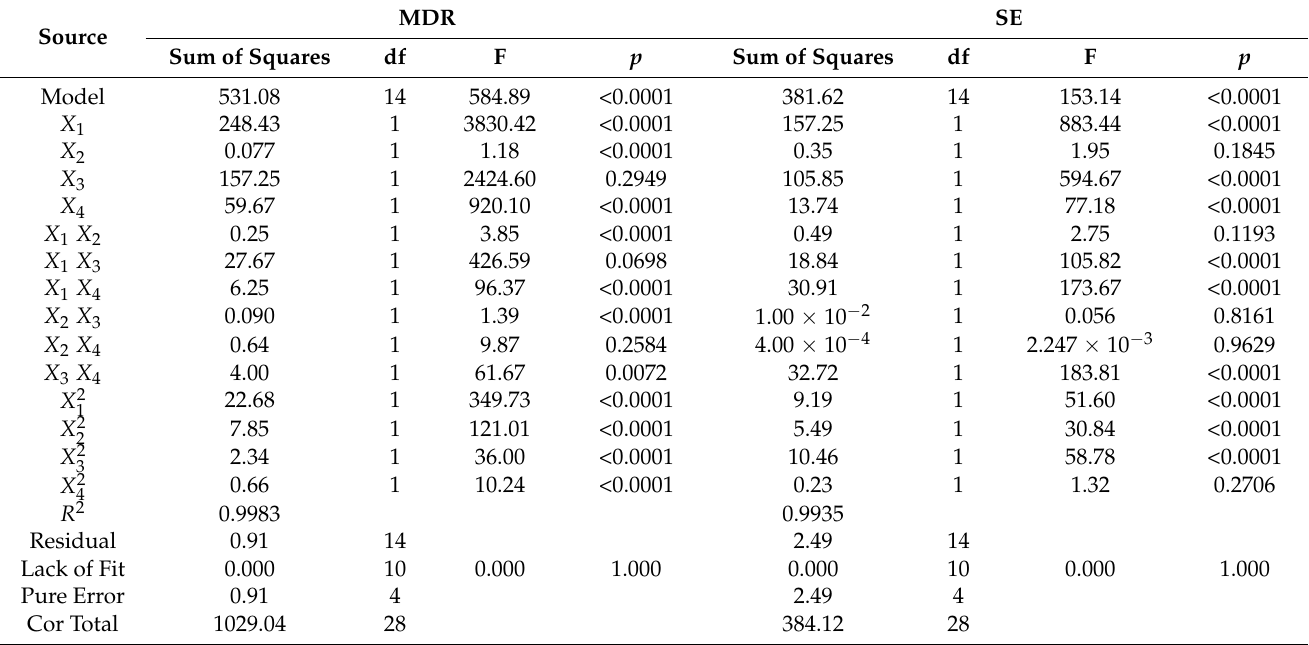
Table 4. ANOVA of test results.